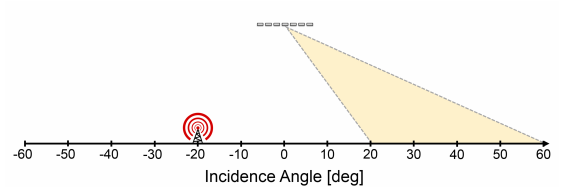
Figure 18. Scenario A: A single interferer is located outside the swath at − 20°. It is transmitting a signal at 40 MHz in